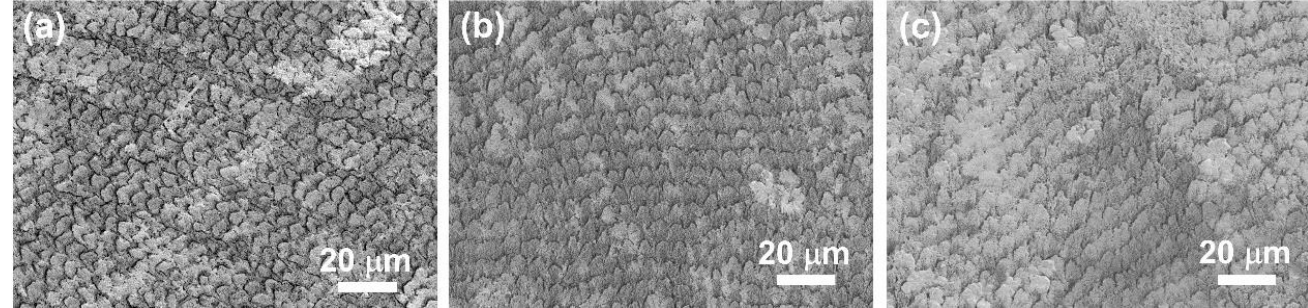
Figure 4. SEM images of tooth enamel after acid etching for ( a ) 30 s, ( b ) 10 min, and ( c ) 20 min.